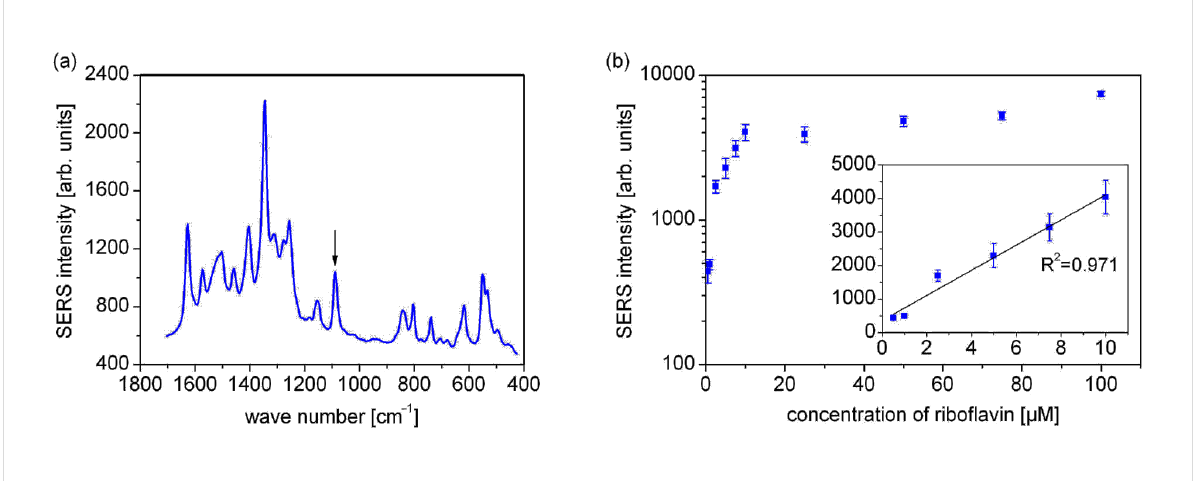
Figure 9: (a) A typical SERS spectrum of riboflavin (5 µM) on enzymatically generated silver nanoparticles measured for an excitation wavelength of 532 nm and (b) the dependence of the integrated SERS intensity at 1087 cm − 1 (flagged with the arrow in part (a)) on the riboflavin concentration. The inset shows the strongly increasing SERS intensity for low riboflavin concentrations on a linear